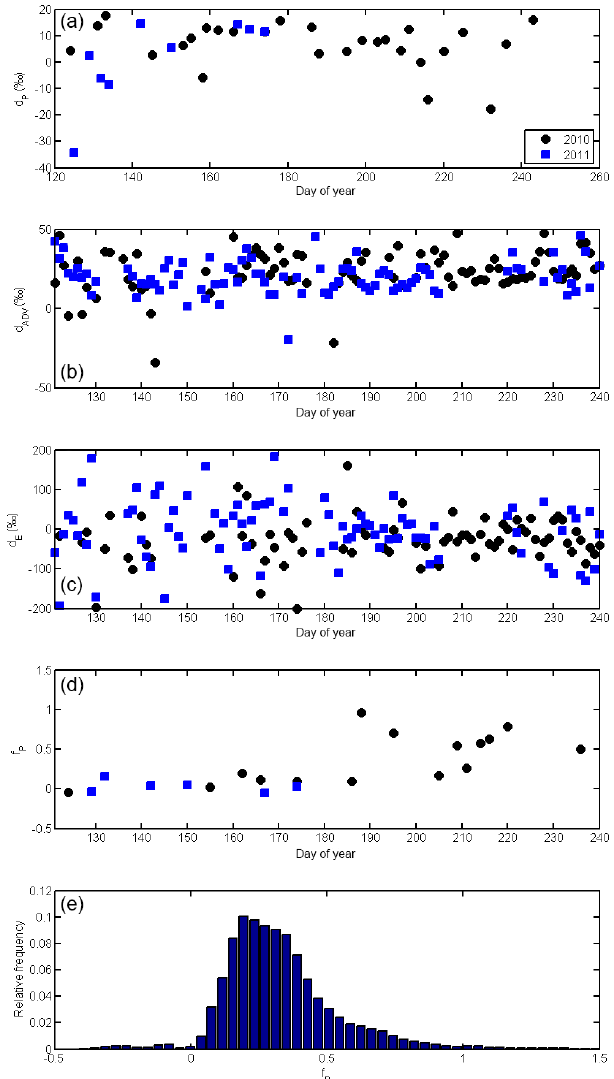
Figure 10. Precipitation recycling ratio estimated using a simple deuterium excess mixing model. The panels from top to bottom rep- resent (a) deuterium excess in precipitation; (b) deuterium excess of water vapor measured at 185m on the tall tower (i.e., approximation of the advection term); (c) deuterium excess of evapotranspiration determined from the tall tower flux ratio method; (d) precipitation recycling ratio; (e) estimate of growing season precipitation recy- cling ratio for 2006–2011 based on precipitation and tall tower iso- tope data and a Monte Carlo